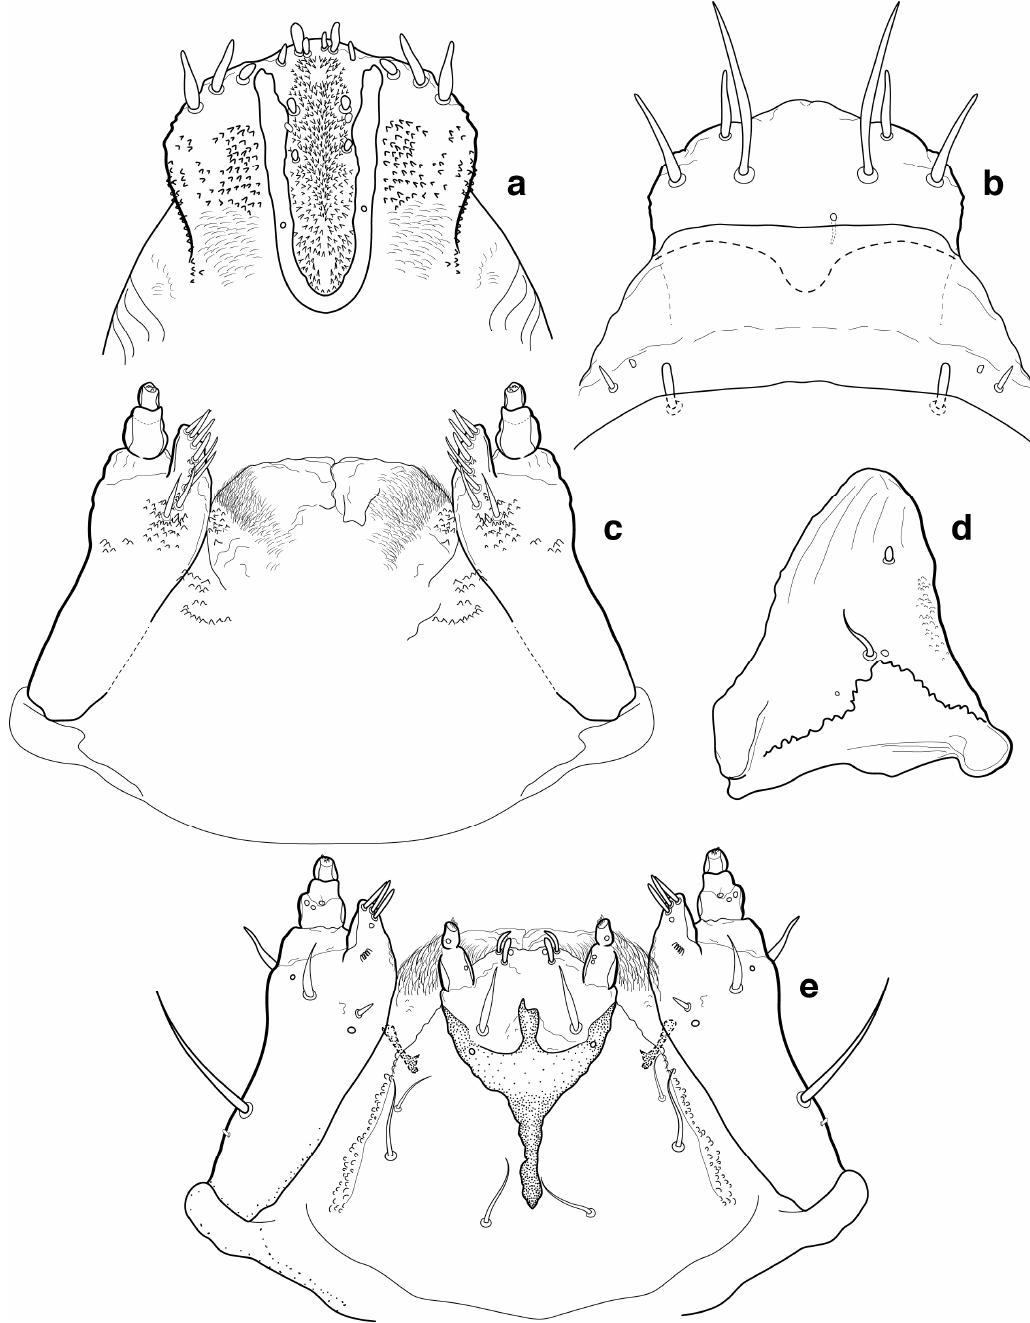
Figure 73. Phacecorynes zamiae mouthparts: ( a ) epipharynx; ( b ) clypeus and labrum; ( c ) maxillae and hypopharynx, dorsal view; ( d ) mandible; and ( e ) labio-maxillary complex, ventral view.